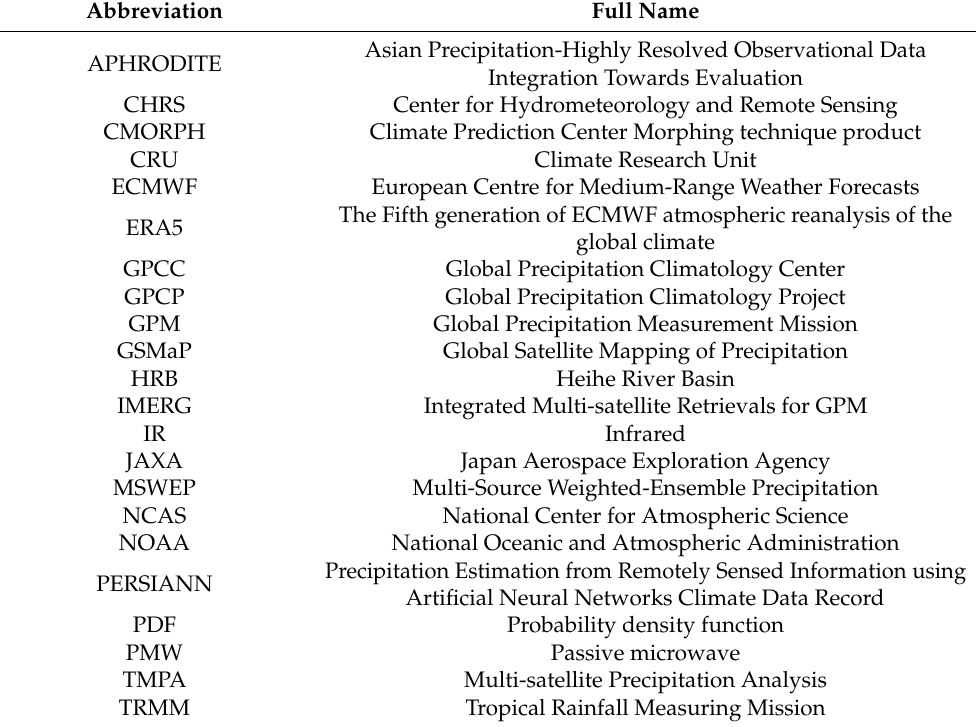
Table A2. Summary of the abbreviations in this